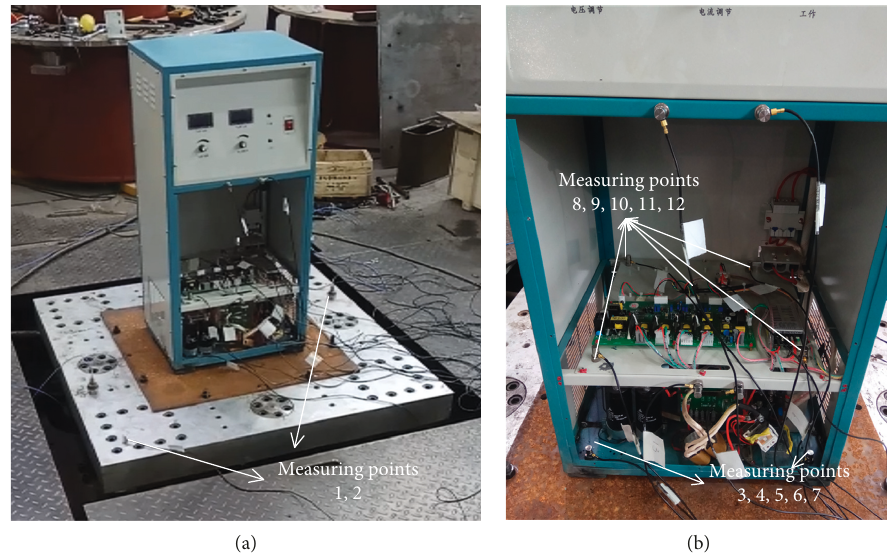
Figure 2: Arrangement of the impact experiment. (a) Measuring points on the impact table. (b) Measuring points in the cabinet.